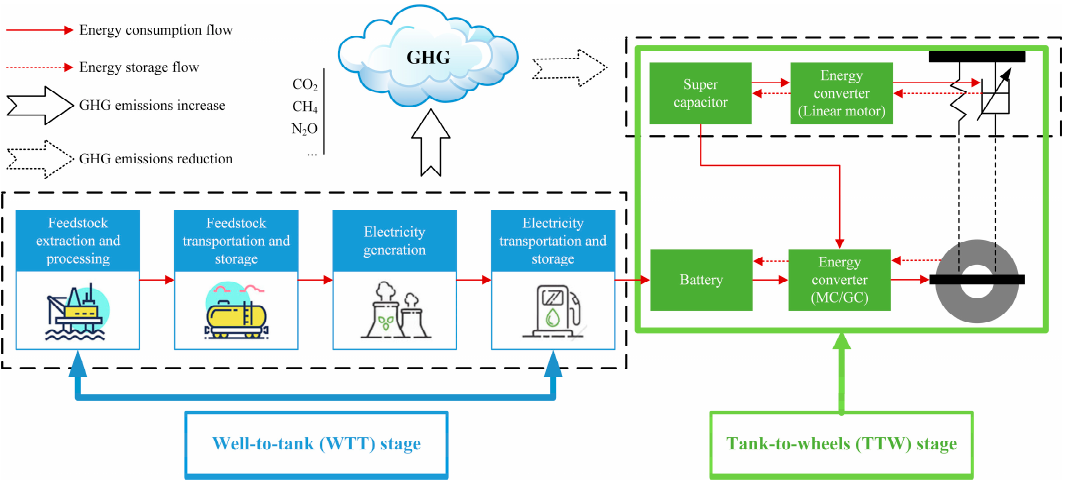
Figure 1. Well-to-wheels (WTW) greenhouse gas (GHG) emissions of a battery electric vehicles (BEV) using regenerative suspension.